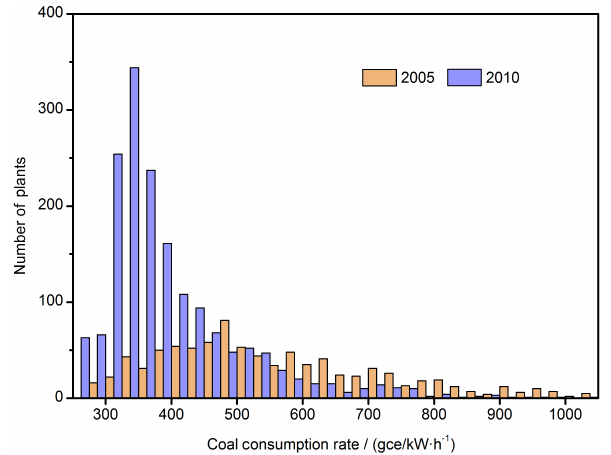
Figure 3. Distribution of coal consumption rates in coal-fired power plants in 2005 and 2010.